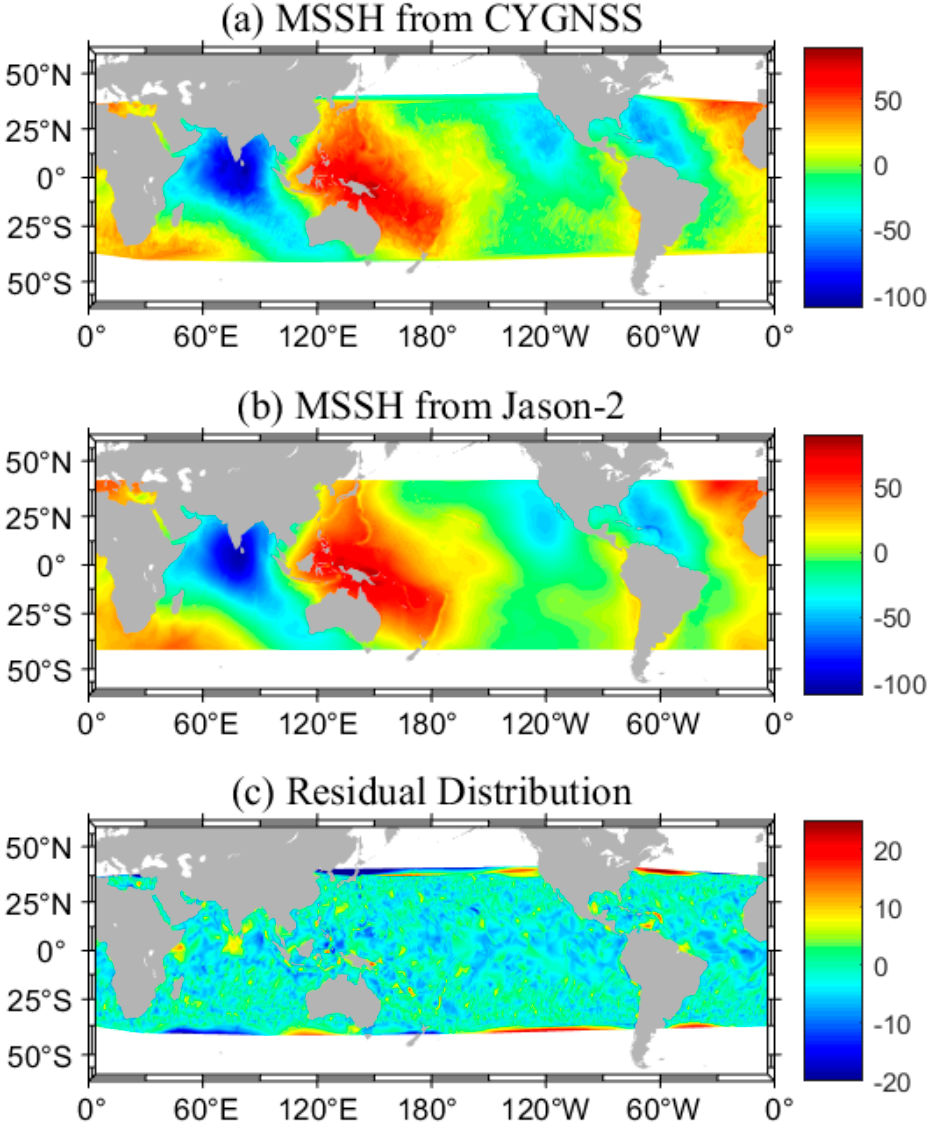
Figure 9. ( a ) Global mean sea surface height estimated by CYGNSS; ( b ) global mean sea surface height obtained by the DTU10 model; ( c ) the residual between CYGNSS and DTU10.